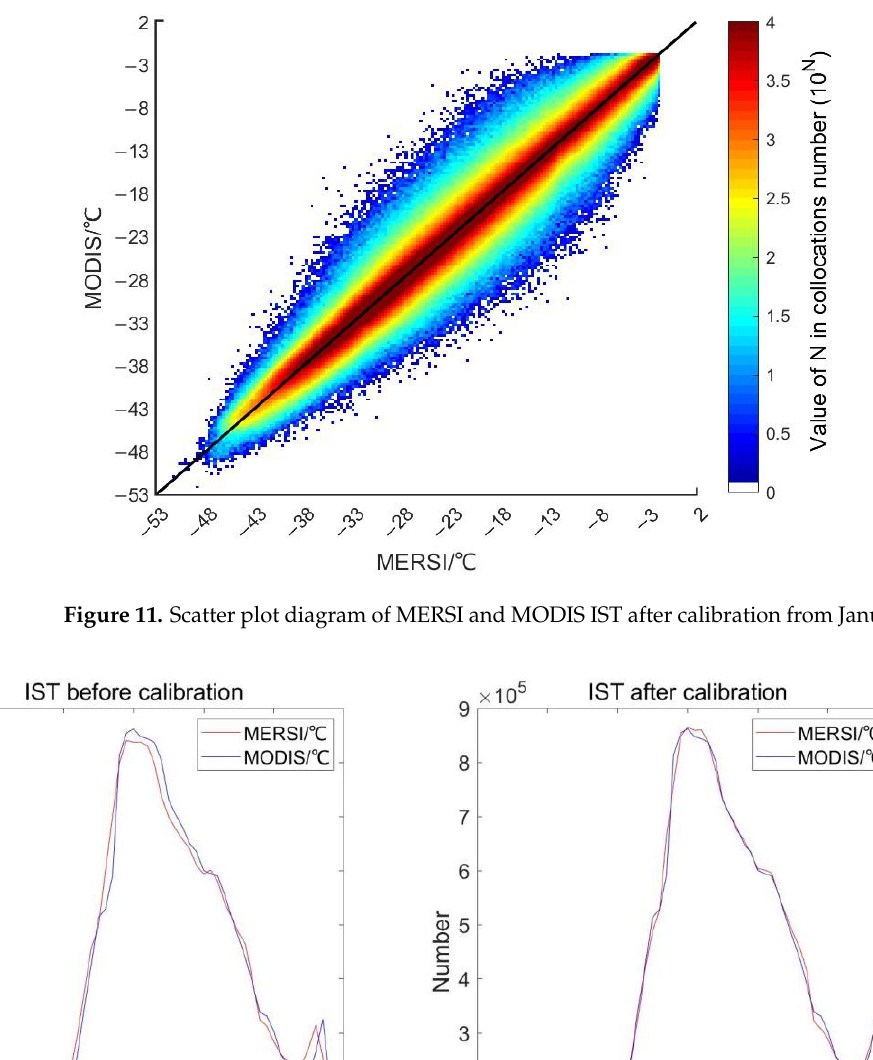
( b ) Figure 13. ( a ) Scatter plot diagram of L4 IST and MERSI IST data in January. ( b ) Scatter plot diagram of L4 IST and MERSI IST data in February. The MERSI IST of thermal infrared channel T b data inversion was compared with the L4 IST data, as shown in Table 8. The correlation between the MERSI IST and L4 IST was >0.7844. From January to May, the monthly mean bias of MERSI IST and L4 IST data was 0.9891 – 2.7510 °C, and the Std was <3.5774 °C. The overall bias of MERSI IST and L4 IST data for five months was 1.8006 °C, the Std was 3.378 °C, and the correlation was 0.9235.